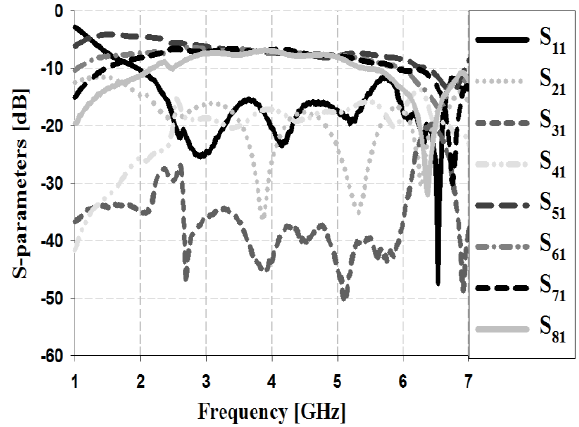
11 of 21 Figure 15. Simulation analysis of phase difference for input Port 2. Table 2. Simulation results of phase difference for 4 × 4 Butler matrix. Output Port Input Port